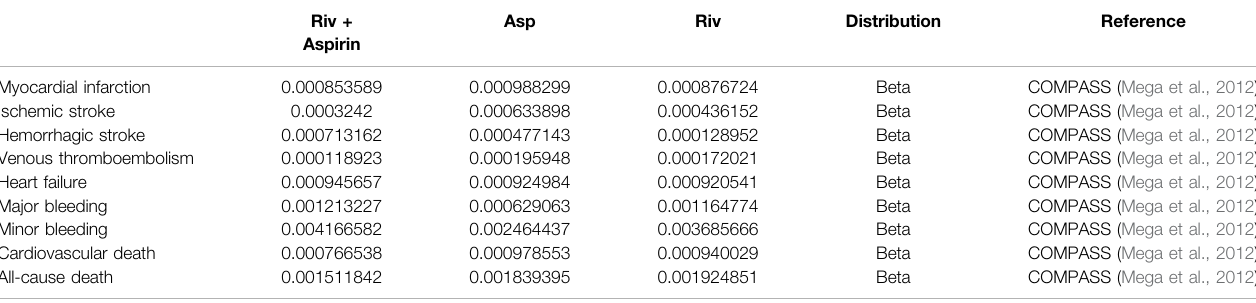
TABLE 1 | Monthly transitional probability of the clinical events.